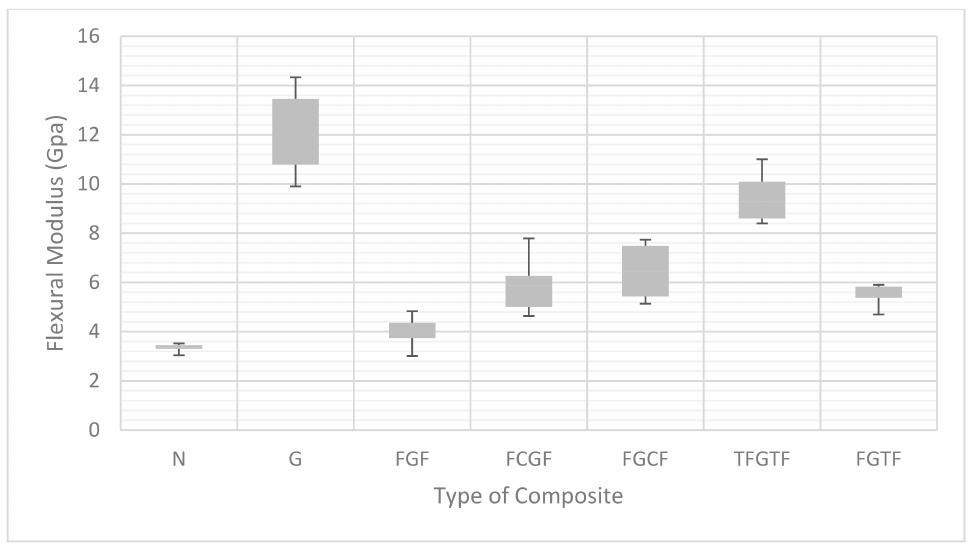
Figure 4. Summary of Flexural Modulus. Note: Nomenclature of the composite sample groups is included in Table